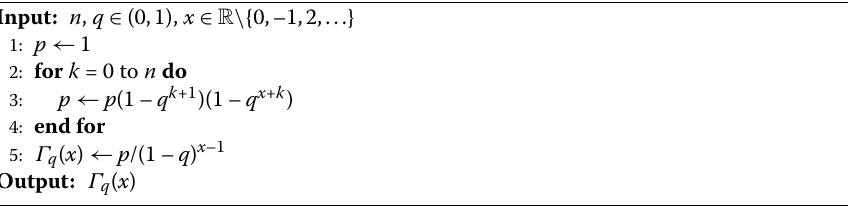
Algorithm 2 The proposed method for calculated Γ q ( x )